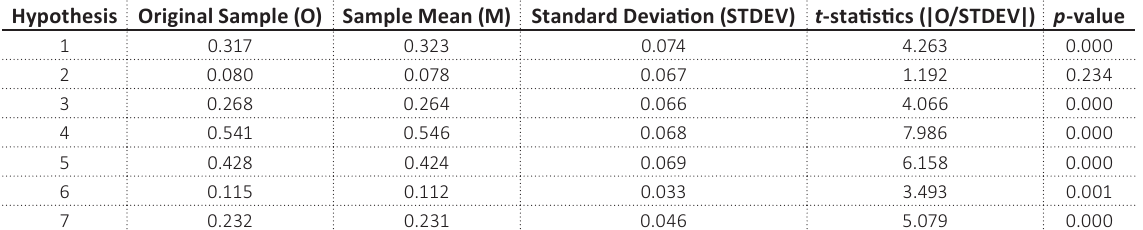
Table 6. Indirect effects